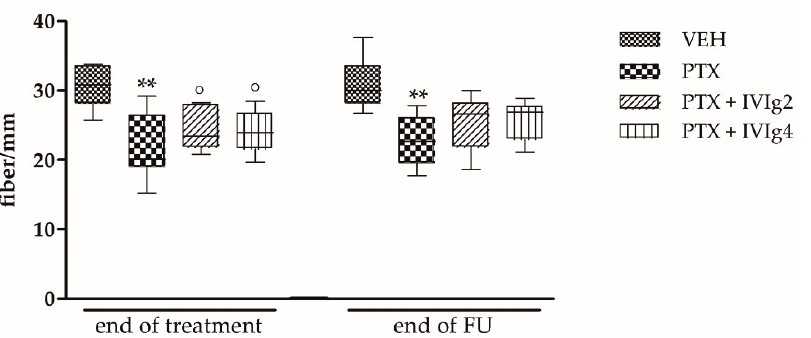
Figure 4. Effects of PTX and IVIg co-treatment on IENF density. IVIg reduces the loss of unmyelinated fibers observed in paclitaxel-treated rats at the end of follow up period. ◦ p < 0.05, ** p < 0.001 vs. VEH ( n = 12 rats/group). Data were analyzed using the non-parametric Kruskal-Wallis test.